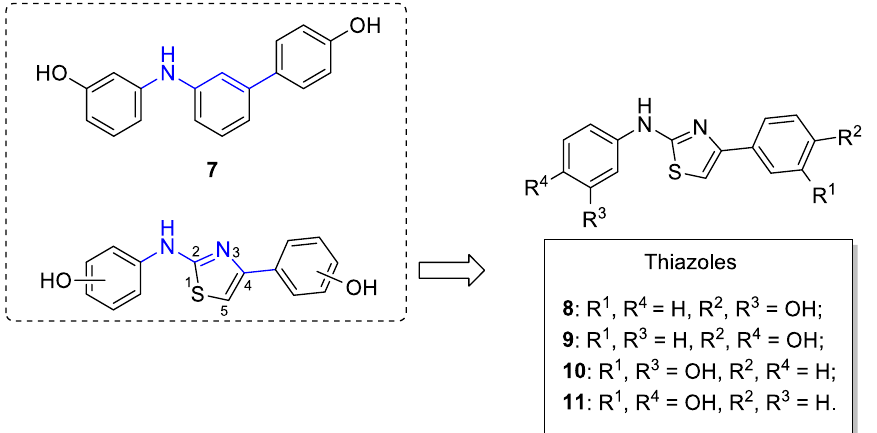
Figure 1. Some representative examples of SIRT1-activating compounds: natural (compounds 1–3 , on the left) and synthetic (compounds 4 – 7 , on the right) SIRT1 activators.